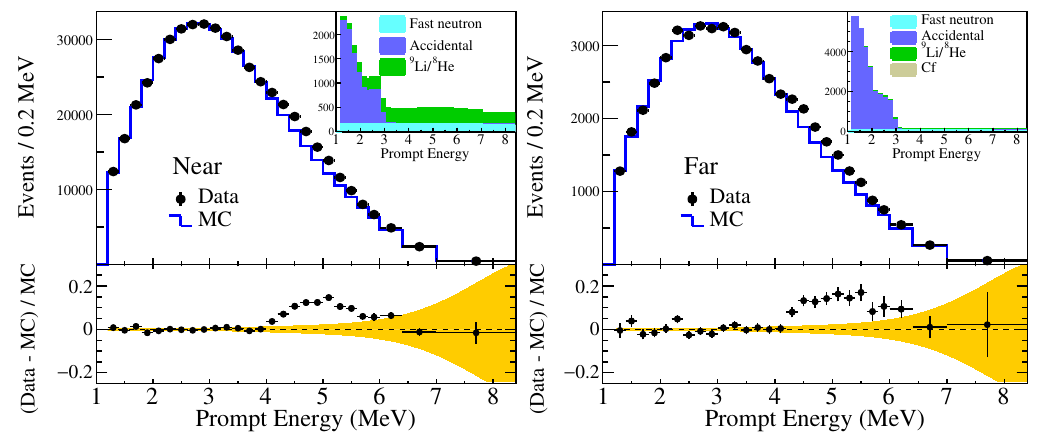
Figure 18 . Observed and expected prompt-energy spectra in the near and far detectors. The Huber and Mueller model is used for the expected spectra. The remaining backgrounds are shown in the insets. The fractional di(cid:11)erence between data and MC is shown in the lower panel. The yellow shaded bands represent the uncertainties of expected spectra. A spectral deviation from the expectation around 5 MeV is larger than the uncertainty of an expected spectrum from the reactor antineutrino model [28,